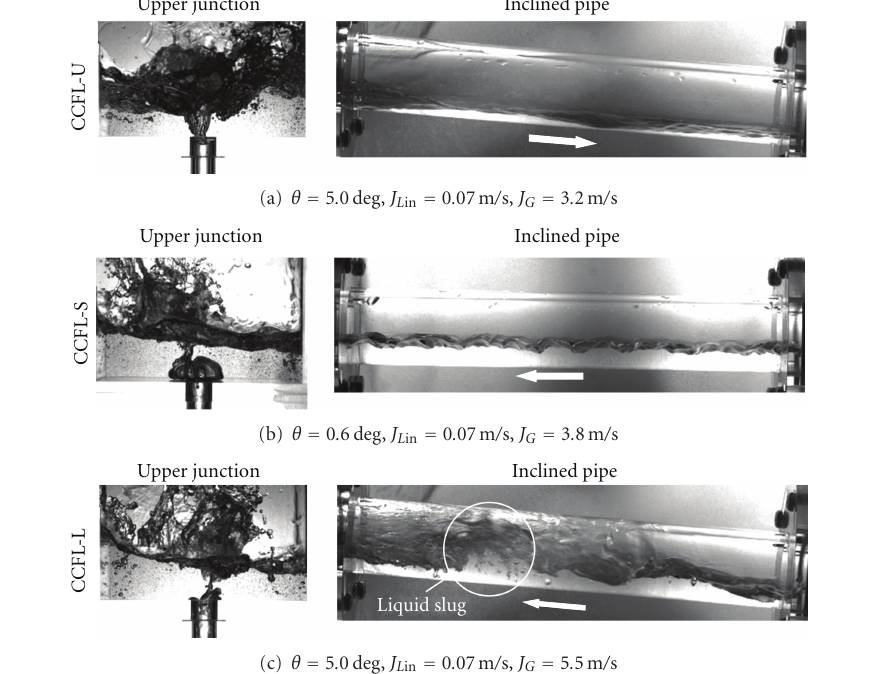
Figure 5: Typical flow pattern at CCFL conditions.